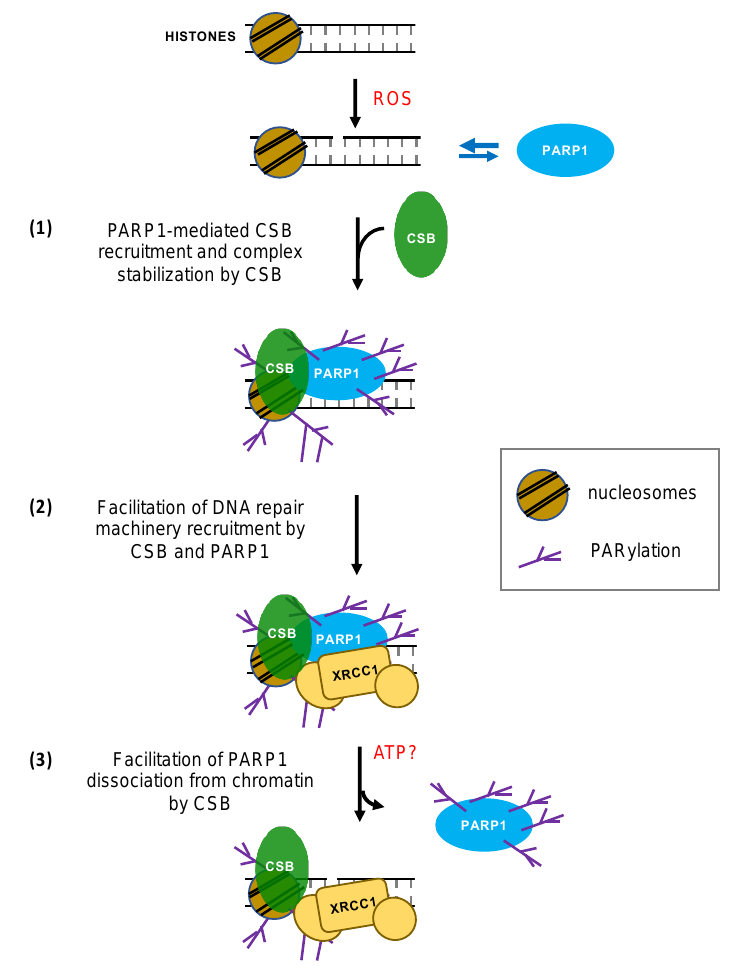
Figure 7. Model for the co-regulations of PARP1 and CSB activity during oxidative stress. In the absence of oxidative stress, both CSB and PARP1 interact with chromatin dynamically. However, in the presence ROS, SSBs are generated, which lead to PARP1 recruitment and activation. CSB interacts with both PARP1 and chromatin, and, together, these multivalent interactions increase the affinity of PARP1 and CSB for damaged chromatin step (1). Once activated by DNA breaks, PARP1 may PARylate CSB, in addition to itself and neighboring proteins, such as histones. The concerted action of PARP1 and CSB facilitates the recruitment of DNA repair proteins, such as XRCC1 step (2). As oxidative stress ensues, PARP1 dissociates from chromatin while CSB remains chromatin-bound step (3), sustaining the PARylation signal and facilitating efficient DNA repair. CSB may help displace PARP1 from chromatin to further enhance DNA repair and/or remodel nucleosomes to create a repair-conducive environment.